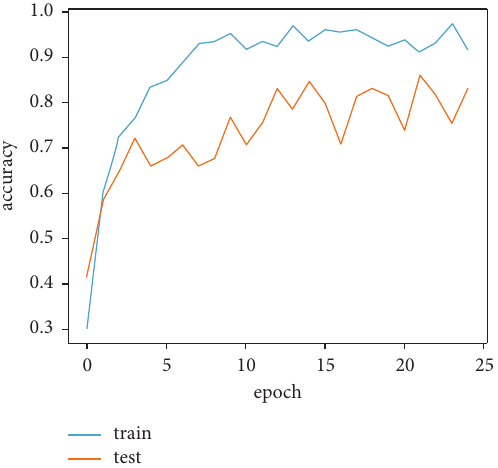
Figure 13: MobileNet.